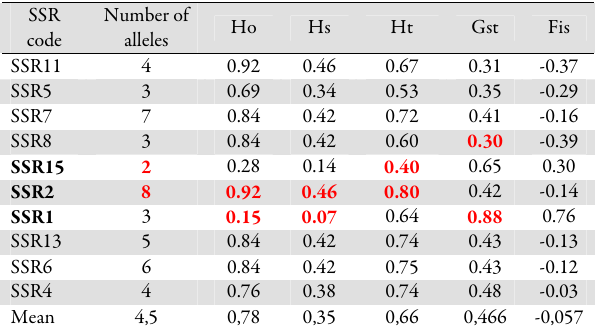
Table 3. Genetic parameters estimated for 10 SSR loci studied in 13 Opuntia ficus-indica cultivars